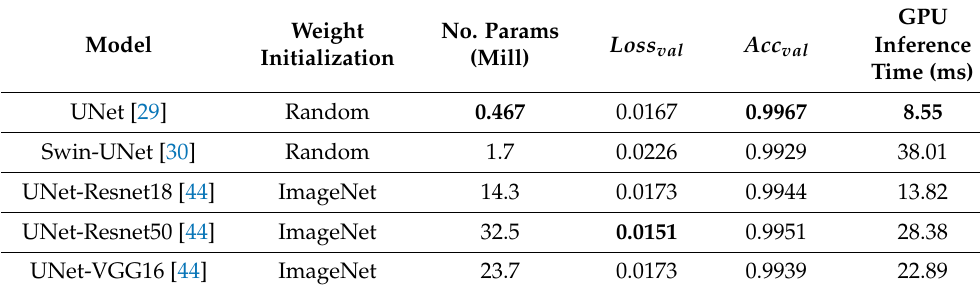
Table 3. Training results for semantic segmentation models for